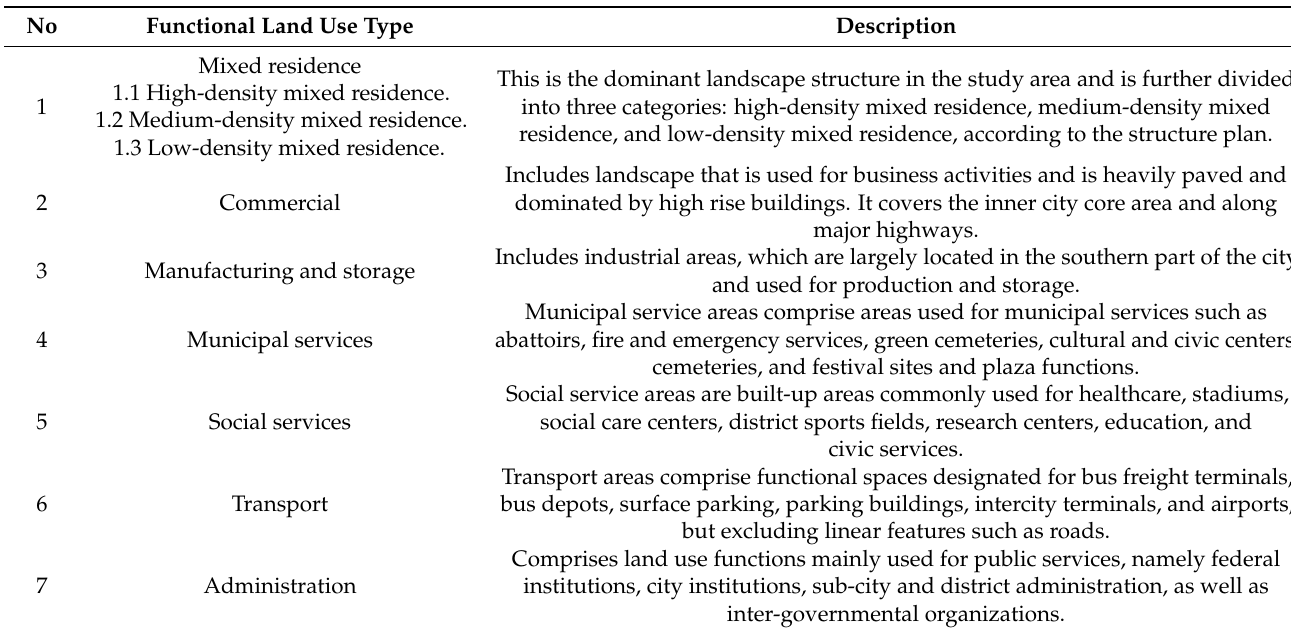
Table 1. Description of functional land uses included in the